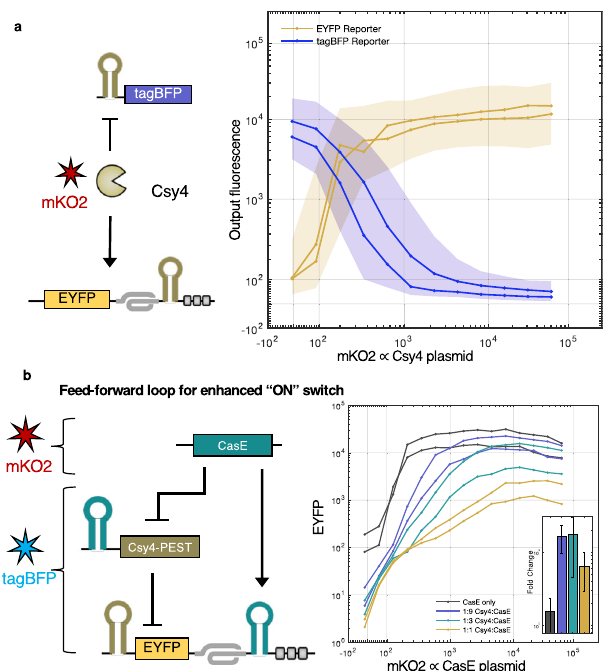
Fig. 4 Dual function of Cas endoRNases in the PERSIST platform. a A tagBFP-encoding OFF-switch reporter (blue line) and an EYFP-encoding ON-switch reporter (yellow line) can be acted on simultaneously by Csy4 in the same cell. The ON/OFF-switch reporters and Csy4 plasmid were co- transfected with plasmids encoding constitutive iRFP720 and mKO2 respectively in order to track their corresponding transfection ef fi ciencies. Summary values were calculated for iRFP720-positive cells. b , A coherent feed-forward loop with dual function Cas protein improves the response of the PERSIST-ON-switch motif. For plasmid ratio calculations, CasE plasmid was maintained at 75 ng. Transfection ef fi ciency of the EYFP reporter and intermediate Csy4 plasmid was tracked by a plasmid encoding constitutive tagBFP while CasE transfection ef fi ciency was tracked by a plasmid encoding constitutive mKO2. Summary values were calculated for tagBFP- positive cells. Fold change (inset) was calculated by normalizing to the EYFP value at the lowest mKO2 bin (see Supplementary Fig. 16) and evaluated at mKO2 = 10,000. Over 1000-fold dynamic range is achieved for certain Csy:CasE ratios compared to roughly 100-fold dynamic range achieved by the ON-switch alone (gray). a , b n = 2 biologically independent samples where each sample represents the evaluation of >1000 transfected cells (HEK293FT). The shaded region is the maximum interquartile range of all cells in each